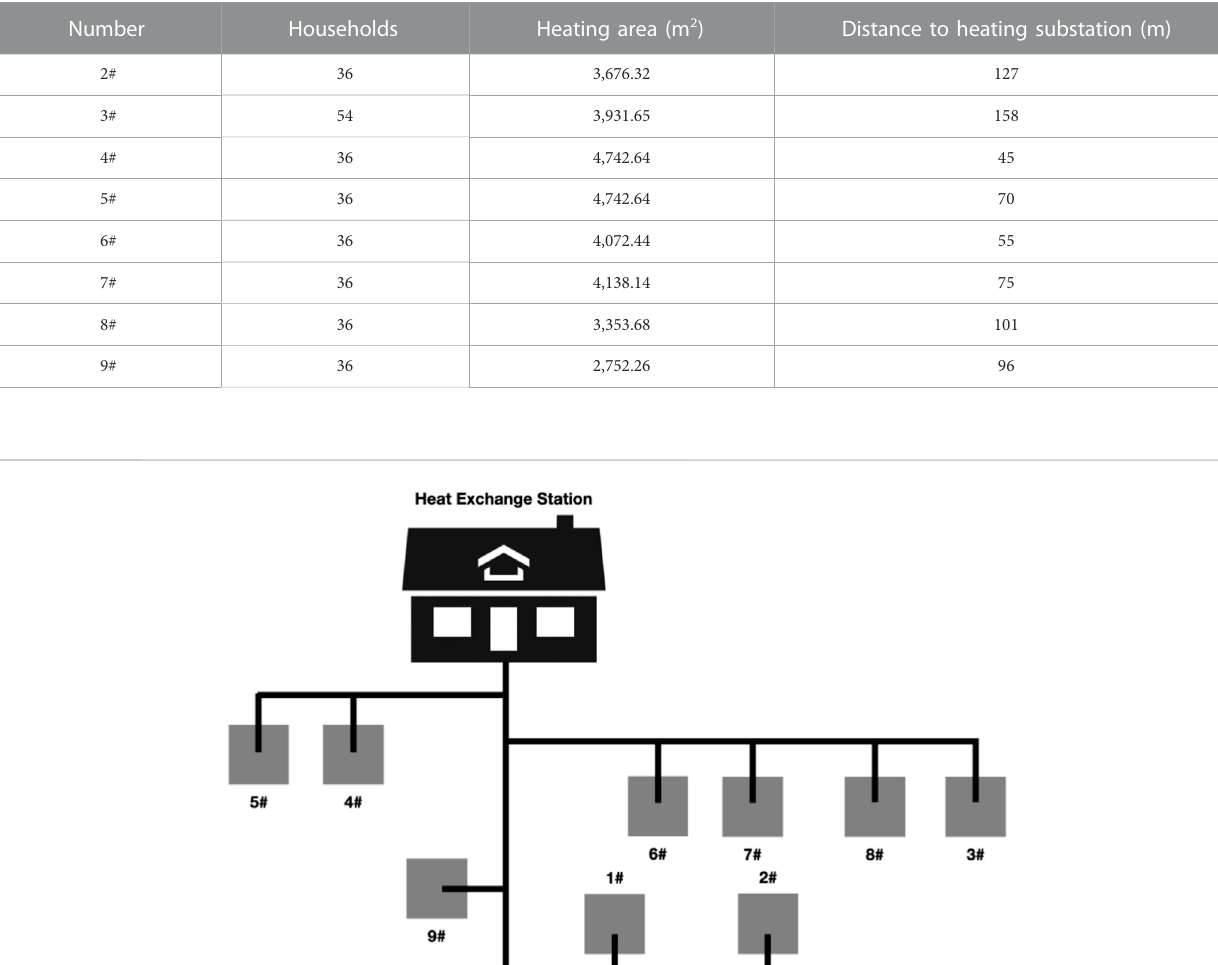
TABLE 2 Low-loop household information.